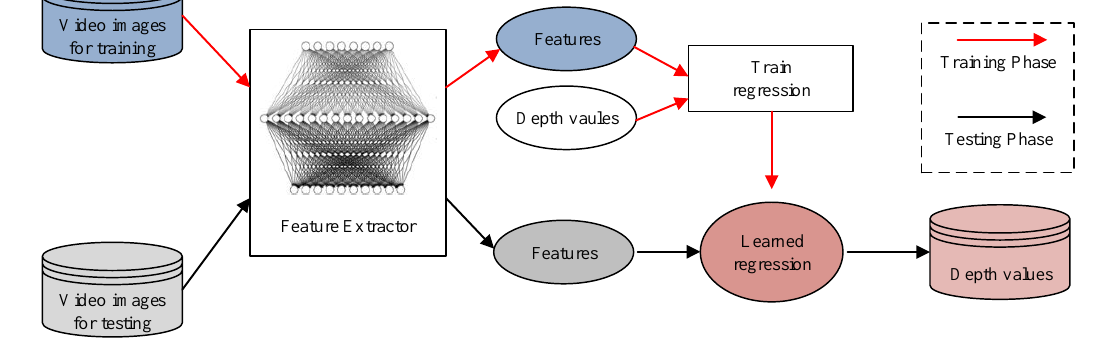
Figure 1. Overall design of the proposed method.